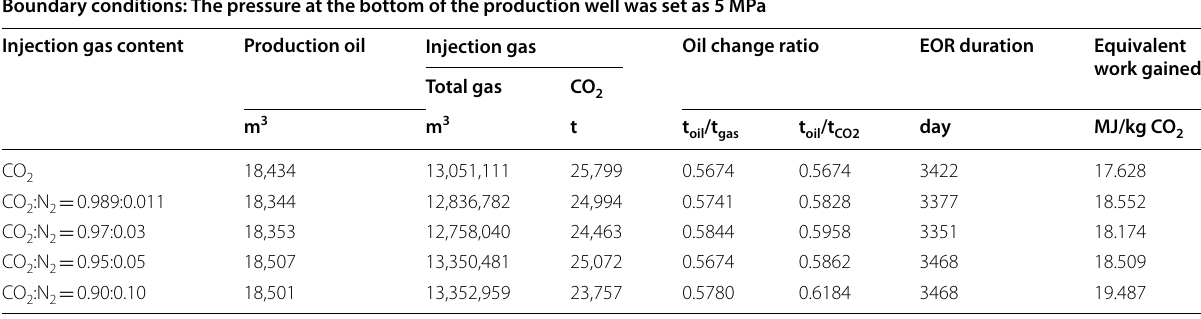
Table 2 Simulation results for a reservoir with typical physical characteristics Boundary conditions: The pressure at the bottom of the production well was set as 5 MPa Injection gas